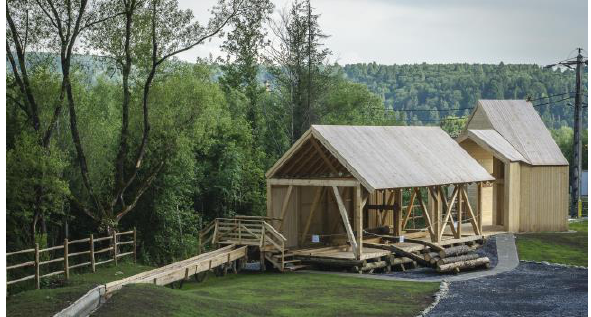
Figure 6. Sawmill, 2016. Zetea,